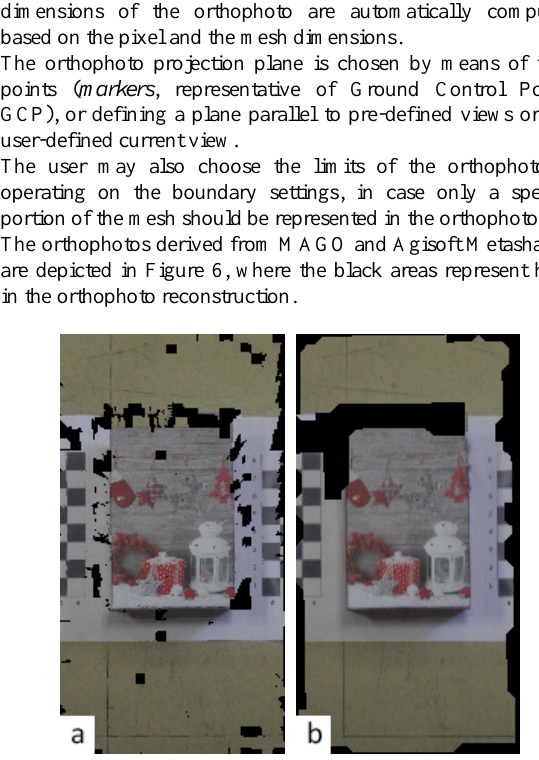
Figure 6. Orthophoto generated by MAGO (a) and by Agisoft Metashape© (b). Figure 6 underlines similarities and differences in the outputs: